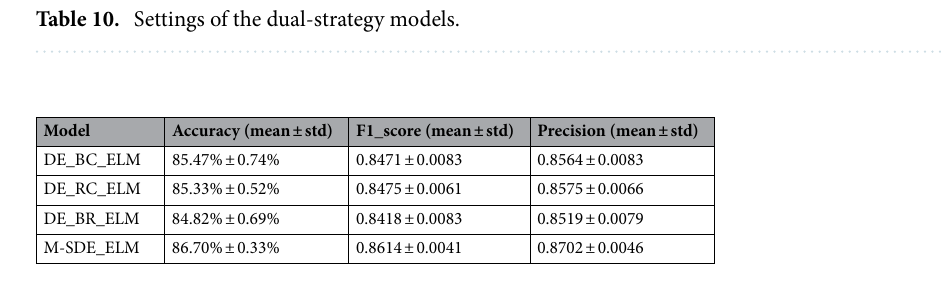
Table 11. Performance comparison between dual-strategy and multi-strategy of models.